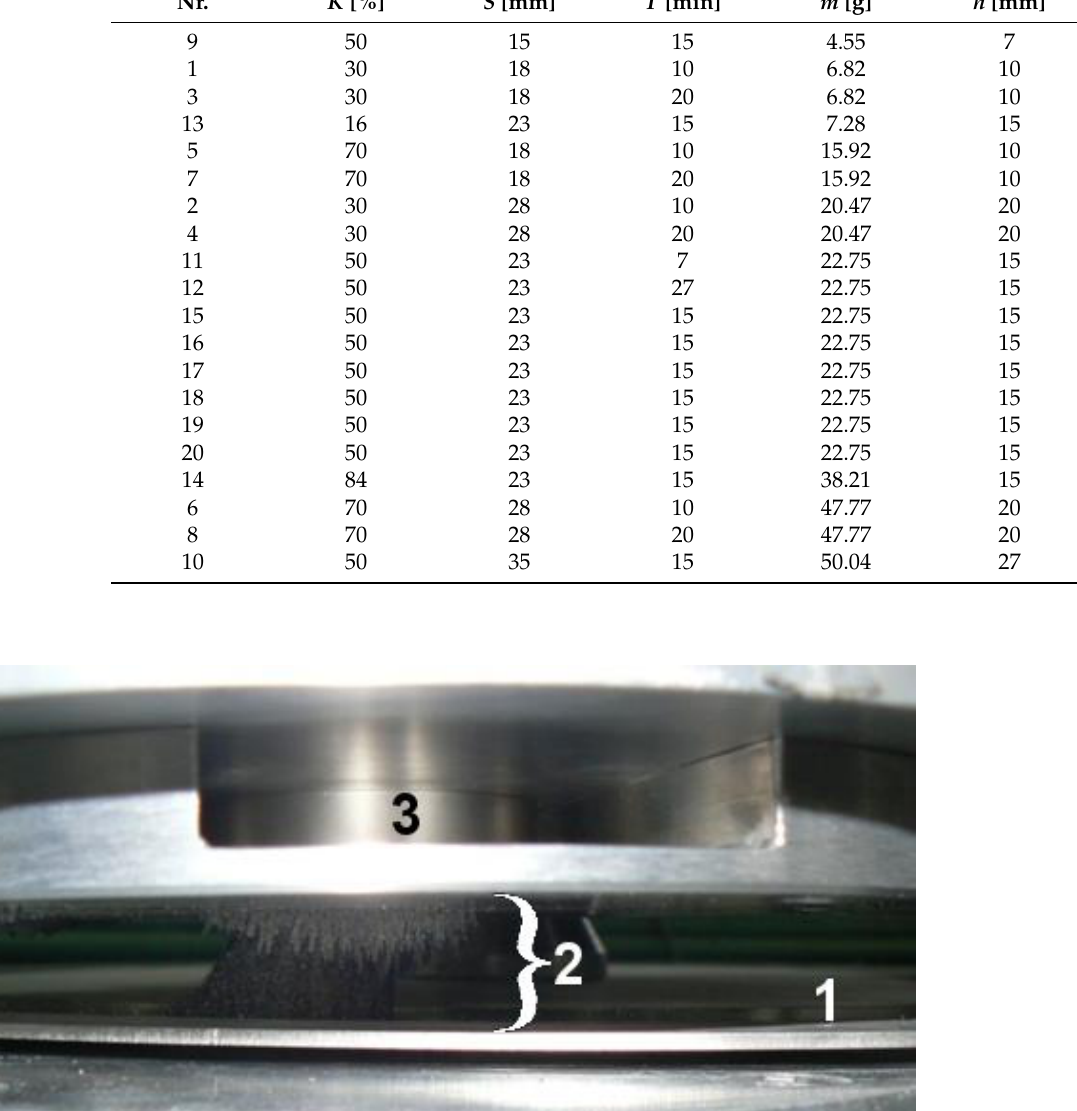
Table 5. Hartley’s five-level, three-factor, rotatable, orthogonal design of experiment with real values. Nr.